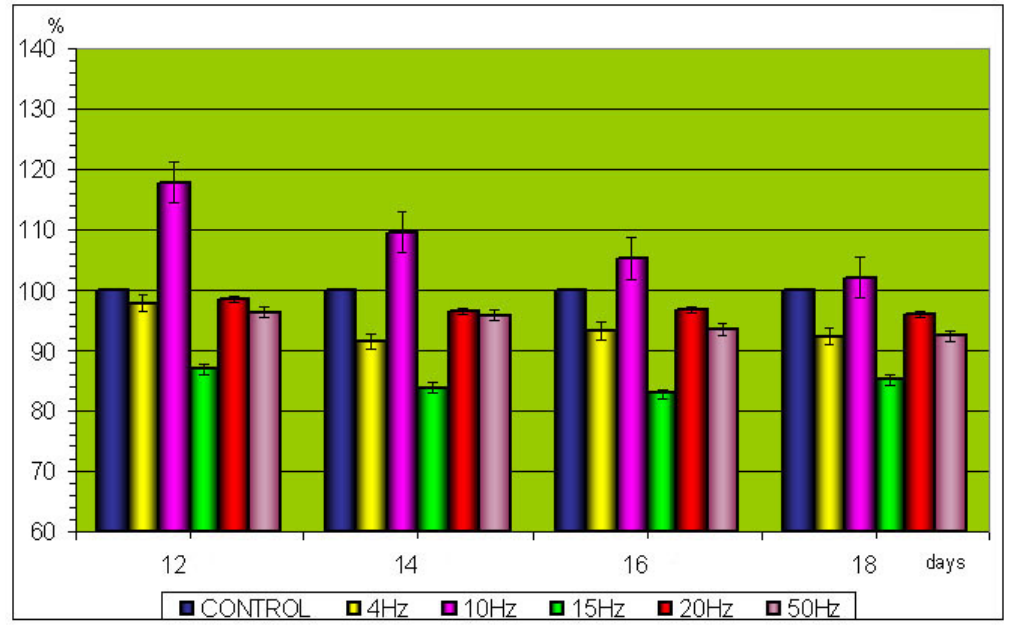
FIGURE 6. The time-dependent process of germination during 18-days incubation in nontreated (control) and EMF- pretreated DW. On abscissa, the time (in days) of seed incubation; on ordinates, percent of the changes of root length comparing to the